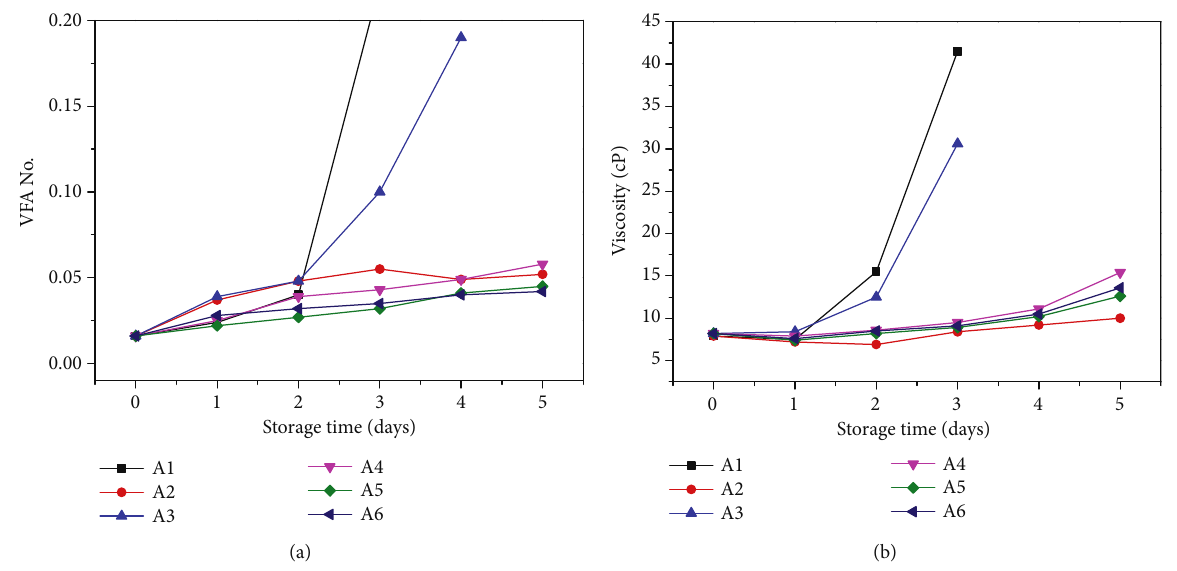
Figure 1: Properties versus the storage time of the fresh NRL: (a) VFA No. and (b)